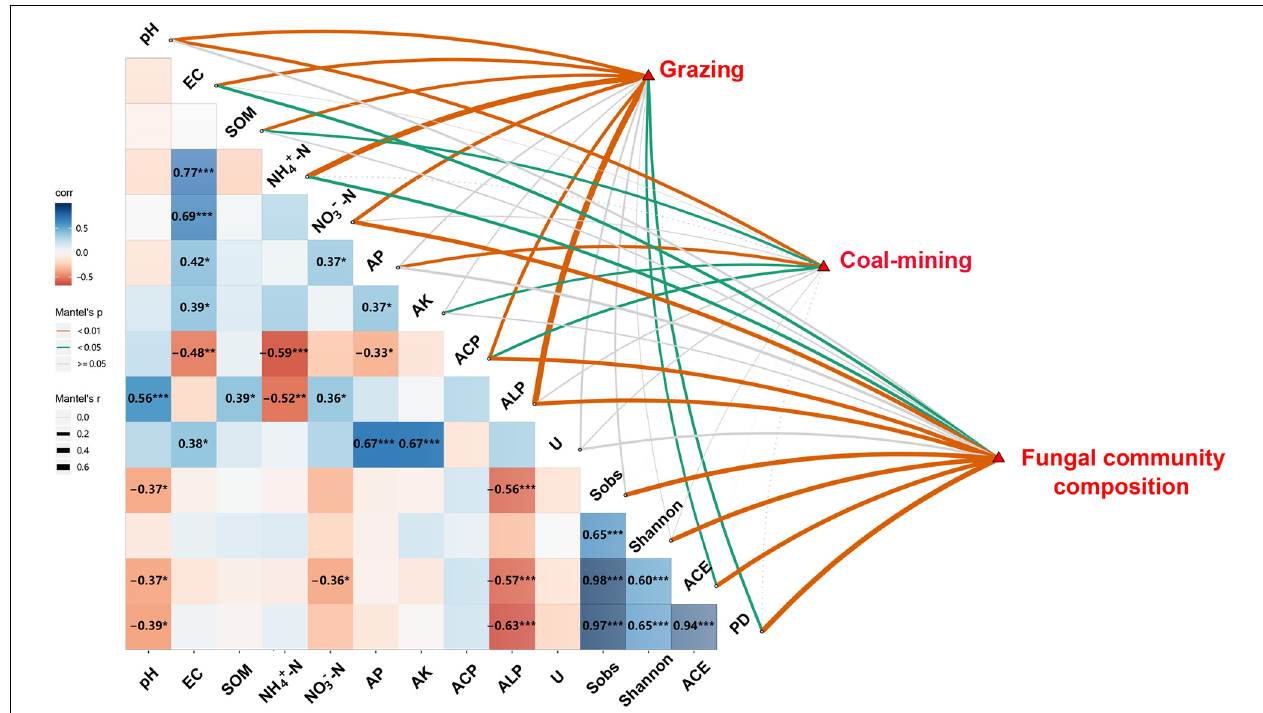
FIGURE 4 | Relationships among distances, routes, edaphic variables, fungal diversity indices, and composition of fungal community. Pairwise comparisons of edaphic variables and fungal diversity indices with a color gradient denoting Pearson’s correlation coefficient (* P < 0.05, ** P < 0.01, *** P < 0.001). Distances, routes, and fungal community composition were related to edaphic variables and fungal diversity indices by Mantel test. SOM, soil organic matter content; EC, electrical conductivity; AK, available potassium; AP, available P; Urease, activity of soil urease; ALP, activity of alkaline phosphatase; ACP, activity of acid phosphatase; Shannon, Shannon–Wiener index; PD, phylogenetic diversity.